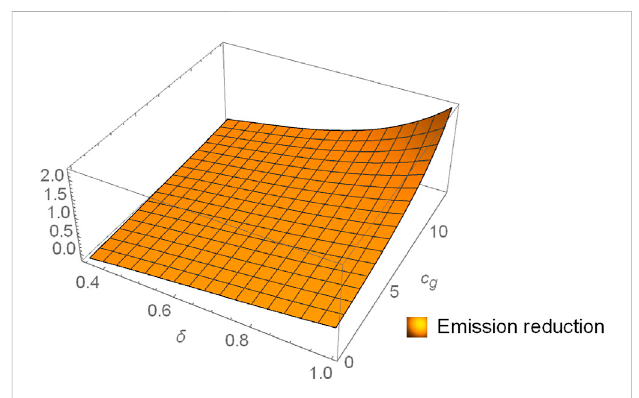
FIGURE 10 The impact of δ and c g on the total amount of emission